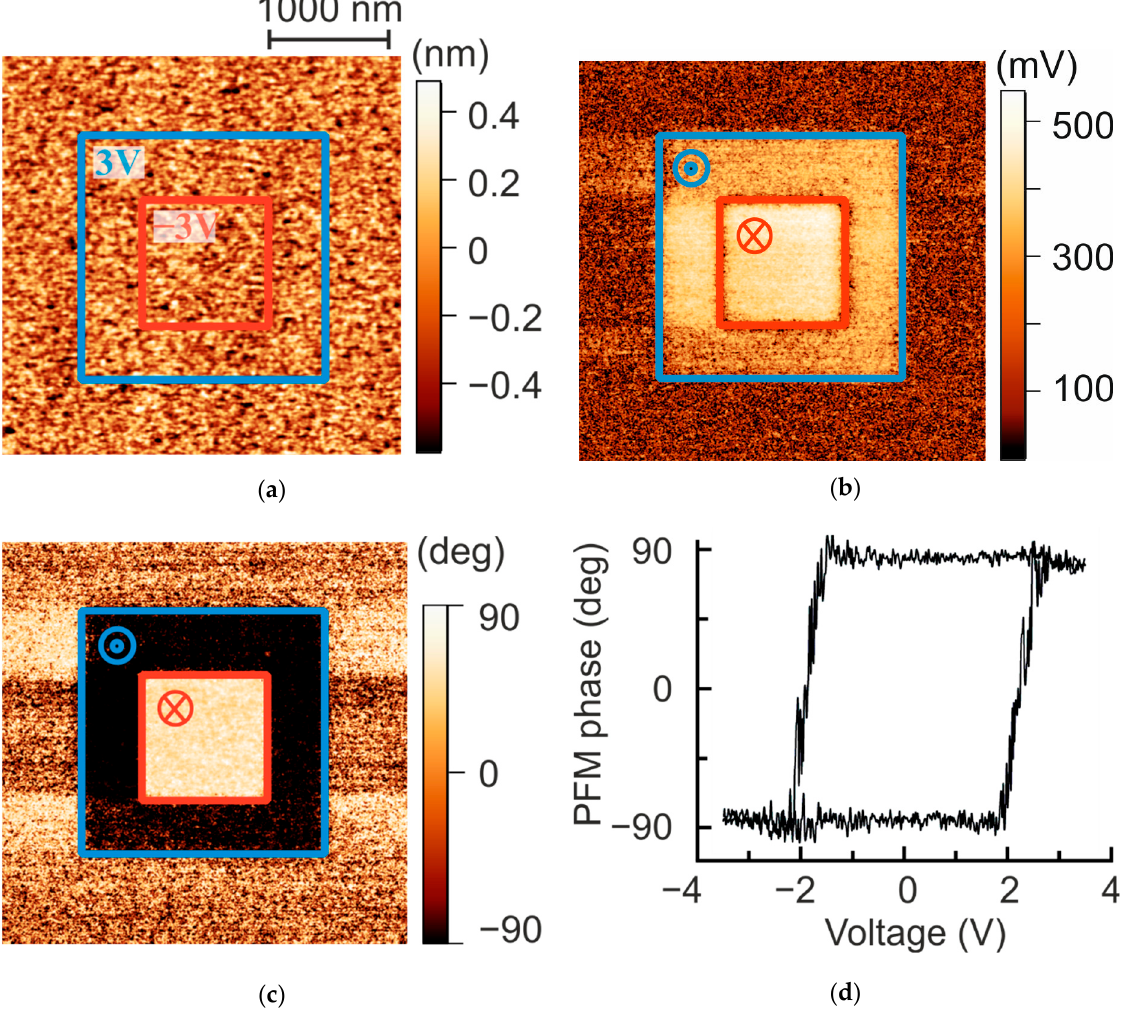
Figure 1. FE properties of STO/LSMO/BTO heterostructures measured with PFM at room temperature in ambient conditions. ( a ) Topography (3.5 × 3.5 µ m 2 ); ( b ) PFM out-of-plane amplitude and ( c ) phase image after poling procedure with DC bias applied to the LSMO bottom electrode, the square domains with downward and upward polarizations written with ± 3 V. PFM imaging was performed with 399 kHz AC voltage of 400 mV applied to the bottom electrode; ( d ) local piezoresponse-voltage hysteresis loop measured on bare BTO film surface in spectroscopic PFM